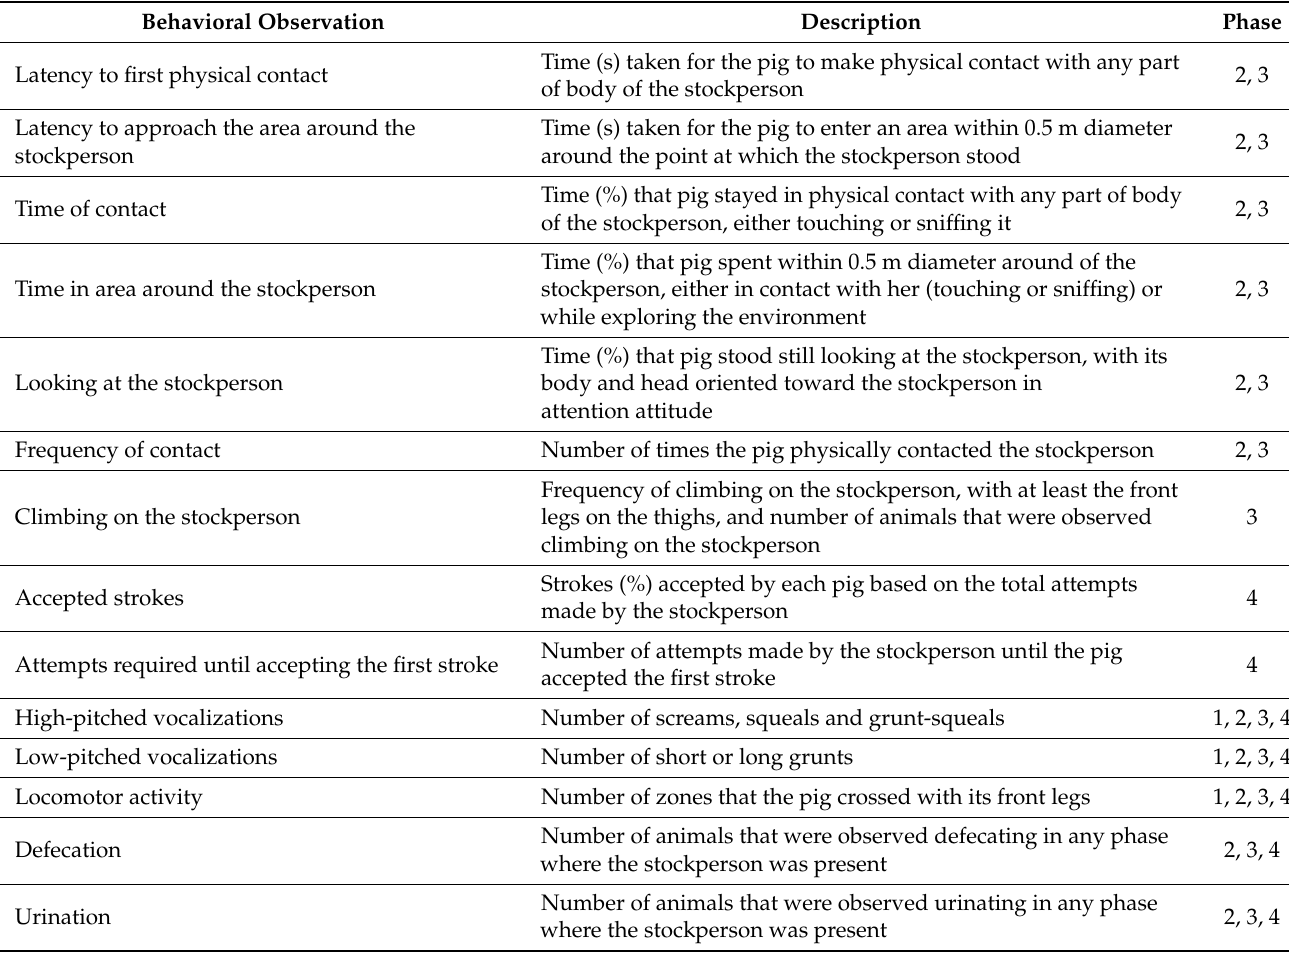
Table 2. Behavioral observations evaluated during the interaction with the stockperson in each phase of the open-field arena test. Behavioral Observation